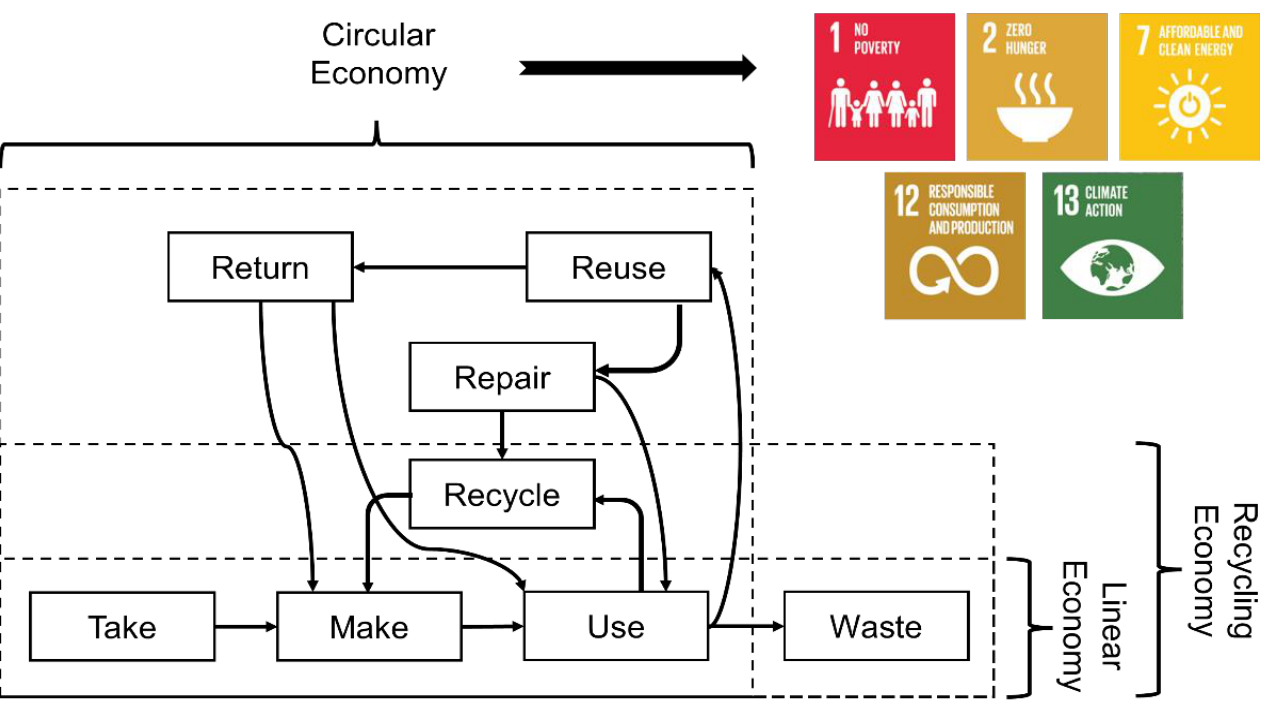
Figure 4. Circular economy approach.